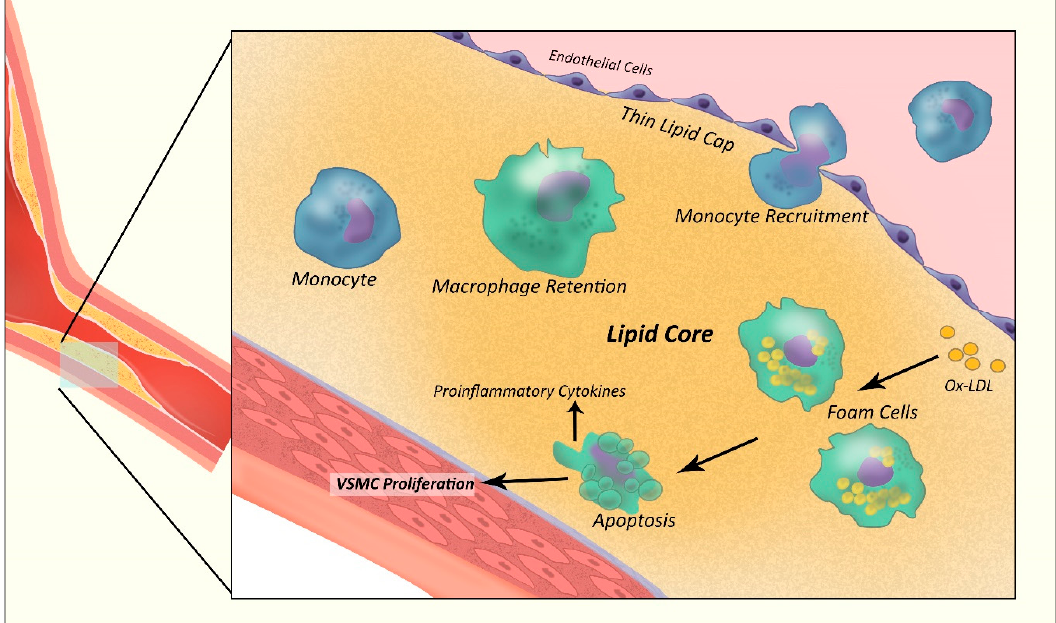
Figure 2. Mechanisms involved in The Generation of a Vulnerable Thin-cap Atherosclerotic plaque. Ox - LDL = oxidized low density-lipoprotein particle; VSMC = vascular smooth muscle cell.